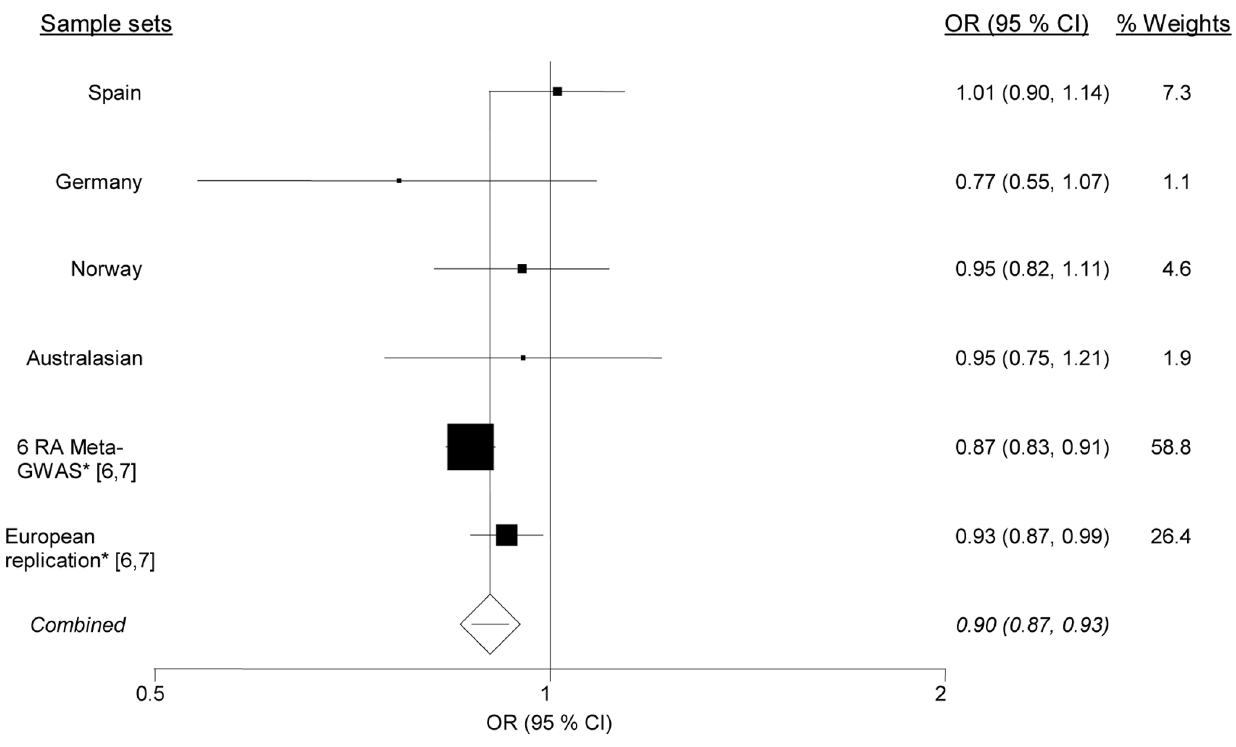
Figure 1. Forest plots of the CD247rs864537 variant in RA patients and healthy subjects including GWAS data from Stahl etal. [ 6 ] and Zhernakova et al. [ 7 ] . The combined analysis included a total of 10,763 RA patients with anti-CPP and 28,879 controls. There was no evidence of heterogeneity between sample sets (Breslow-Day test for heterogeneity p=0.12).